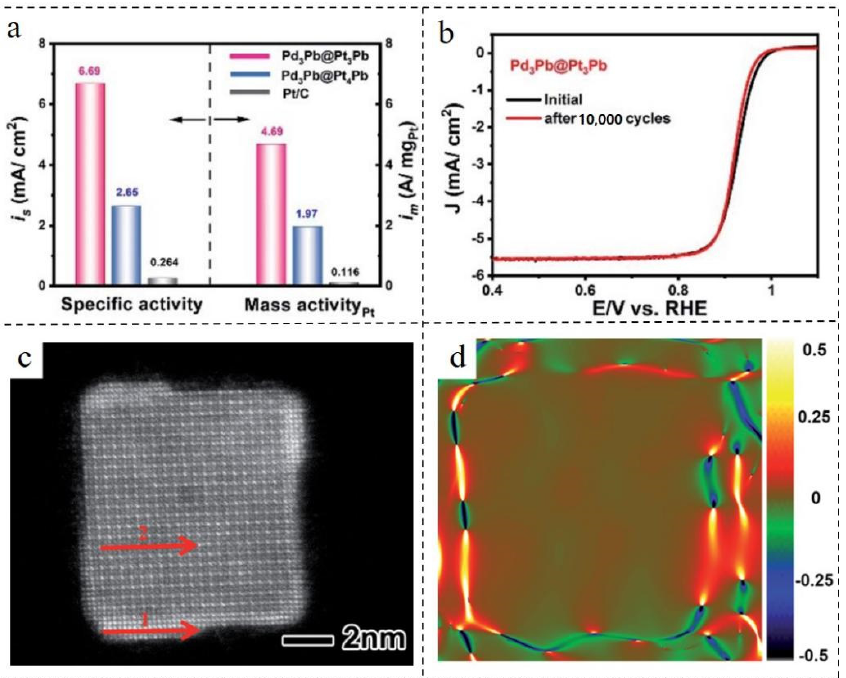
Figure 10. ( a ) Mass activity and specific activity at 0.9 V RHE of Pd 3 Pb@Pt 3 Pb, Pd 3 Pb@Pt 4 Pb and Pt/C. ( b ) LSV polarization curves (100 mV·s − 1 ) of the Pd 3 Pb@Pt 3 Pb/C nanocubes before and after 10,000 cycles. ( c ) Aberration-corrected HAADF-STEM image of the Pd 3 -Pb@Pt 3 Pb nanocubes. ( d ) Mapping image of the ε xx distribution of ( c ). Reproduced with permission from [106]. Copyright © 2022, Royal Society of Chemistry.